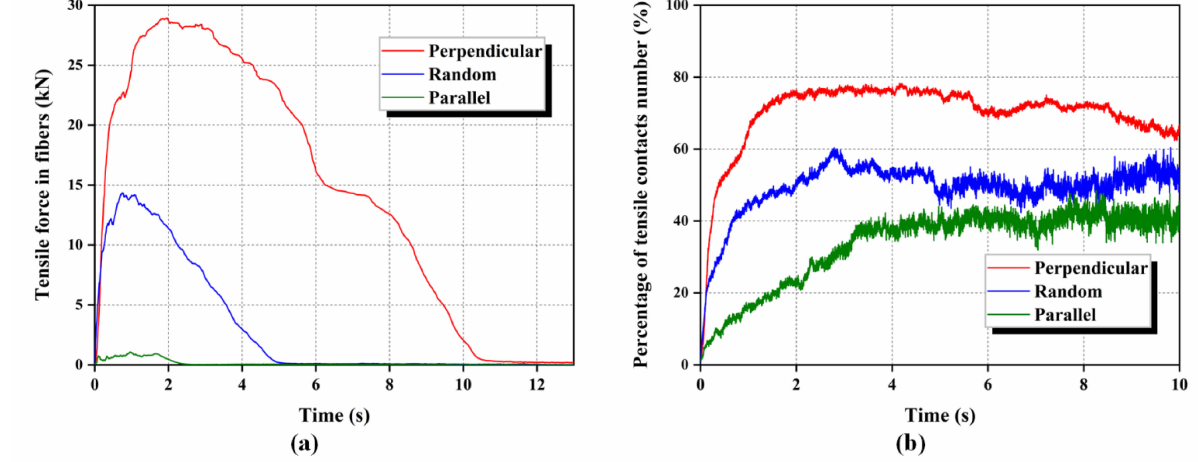
Figure 18. Evolution of tensile force for differently oriented fibers during the seepage: ( a ) tensile force developed in fibers, ( b ) the proportion of the number of tensile contacts in